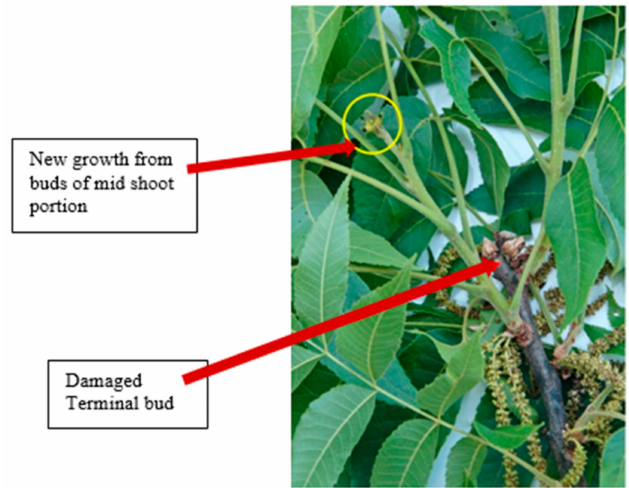
Figure 5. Growth from primary buds below the terminal bud after the terminal bud killed by freeze on 16 April 2018